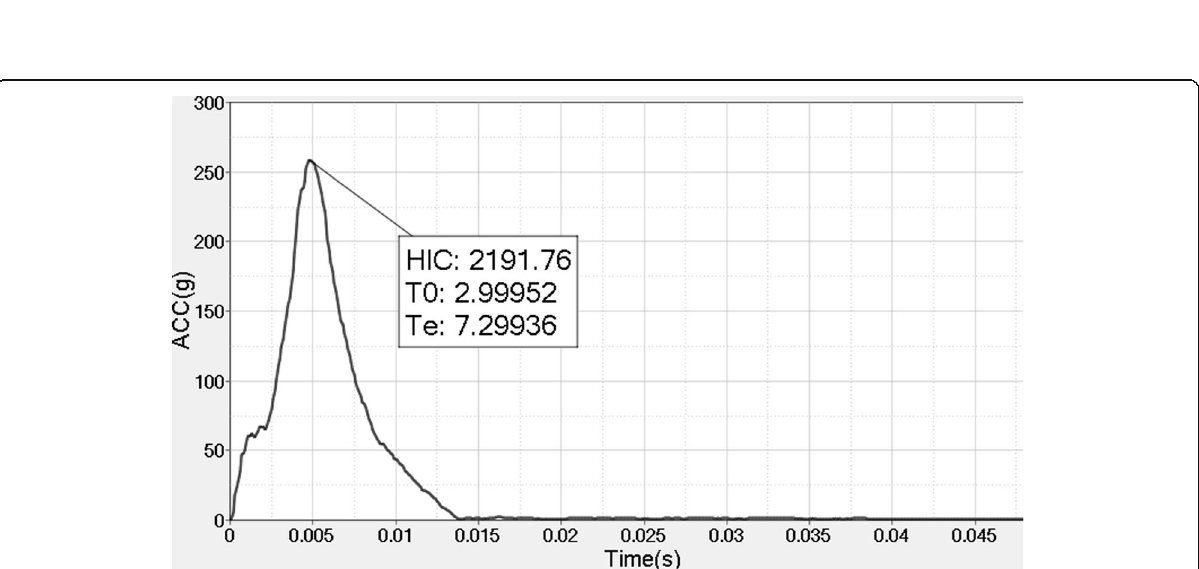
Fig. 12 The rider-car door collision process without the airbag protection at the opening angle of 60°